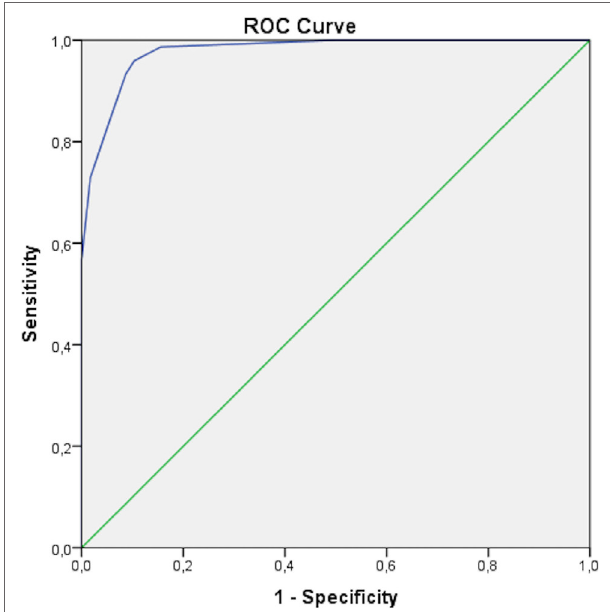
FigUre 1 | Receiver operating characteristic (ROC) curve obtained for adult periodic fever, aphthous stomatitis, pharyngitis, and cervical adenitis (PFAPA) patients and subjects with fever of unknown origin as control group. The area under curve is of 0.978 (95% CI 0.958–0.998), corresponding to sensitivity